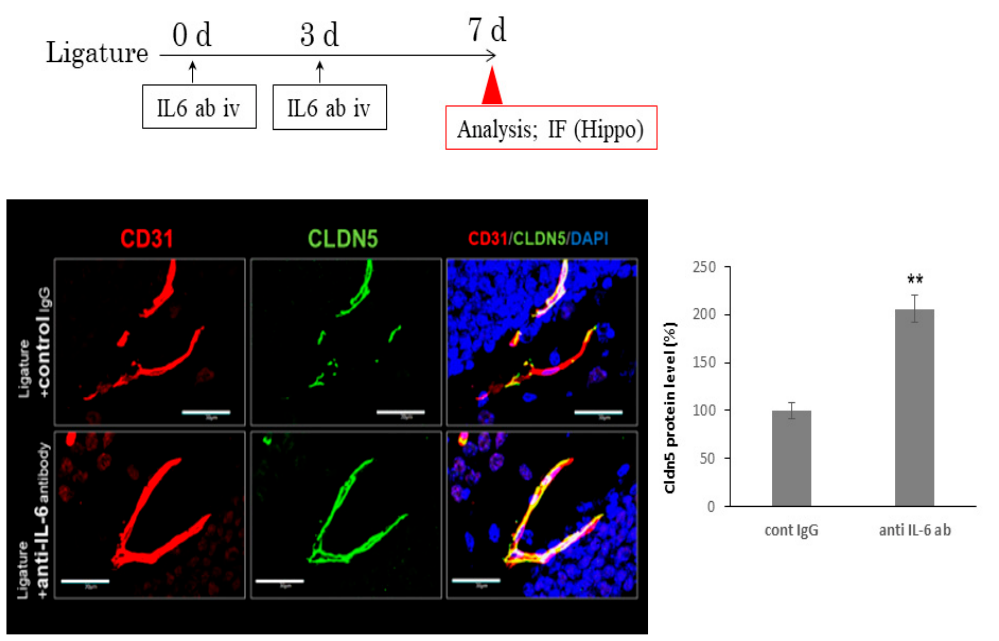
Figure 5. IL-6 antibody prevented the decrease in the levels of claudin 5 induced by PD. Application of IL-6 antibody schedule is shown in scheme. Representative image of claudin 5 (green) is shown along the vessel labeled with endothelial marker (CD31). Blue shows nuclear. Bar = 30 µ m. Bar graph shows the ratio area of the claudin 5 expression in the vessel (mean ± SE, n = 10/group). ** p < 0.01, significantly different from the control, Student’s t- test.